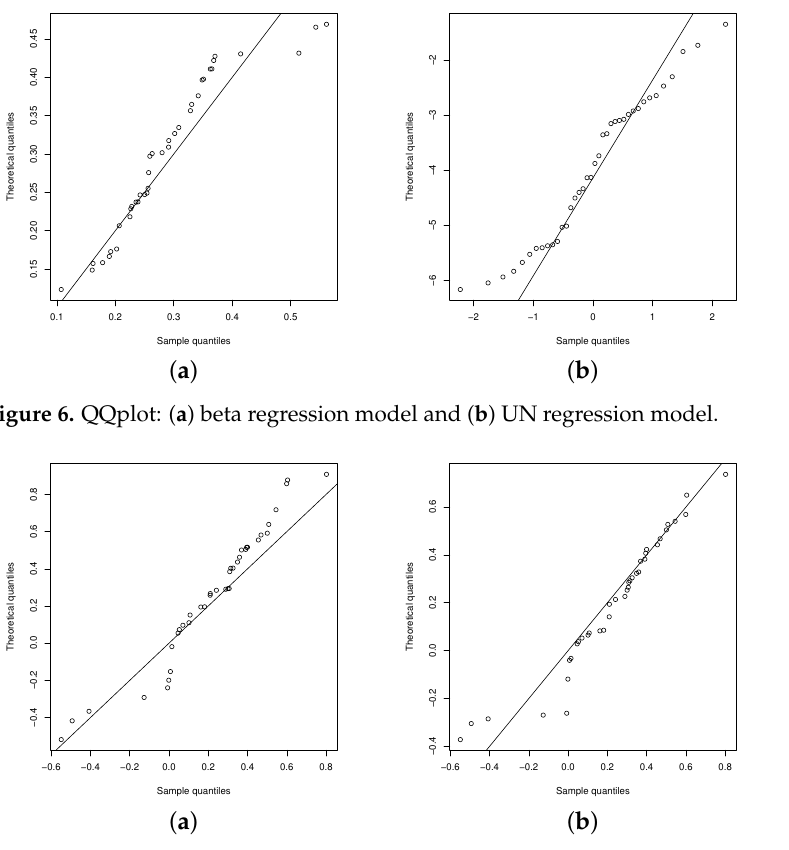
Figure 7. QQplot: ( a ) UPN regression model and ( b ) USPN regression